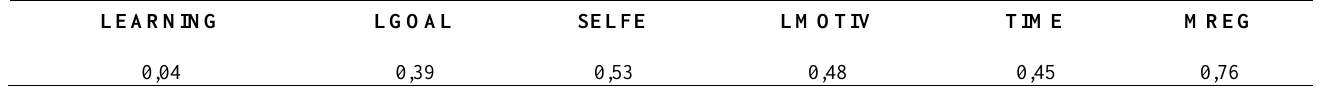
Table 8: R2 values for the six endogenous latent variables